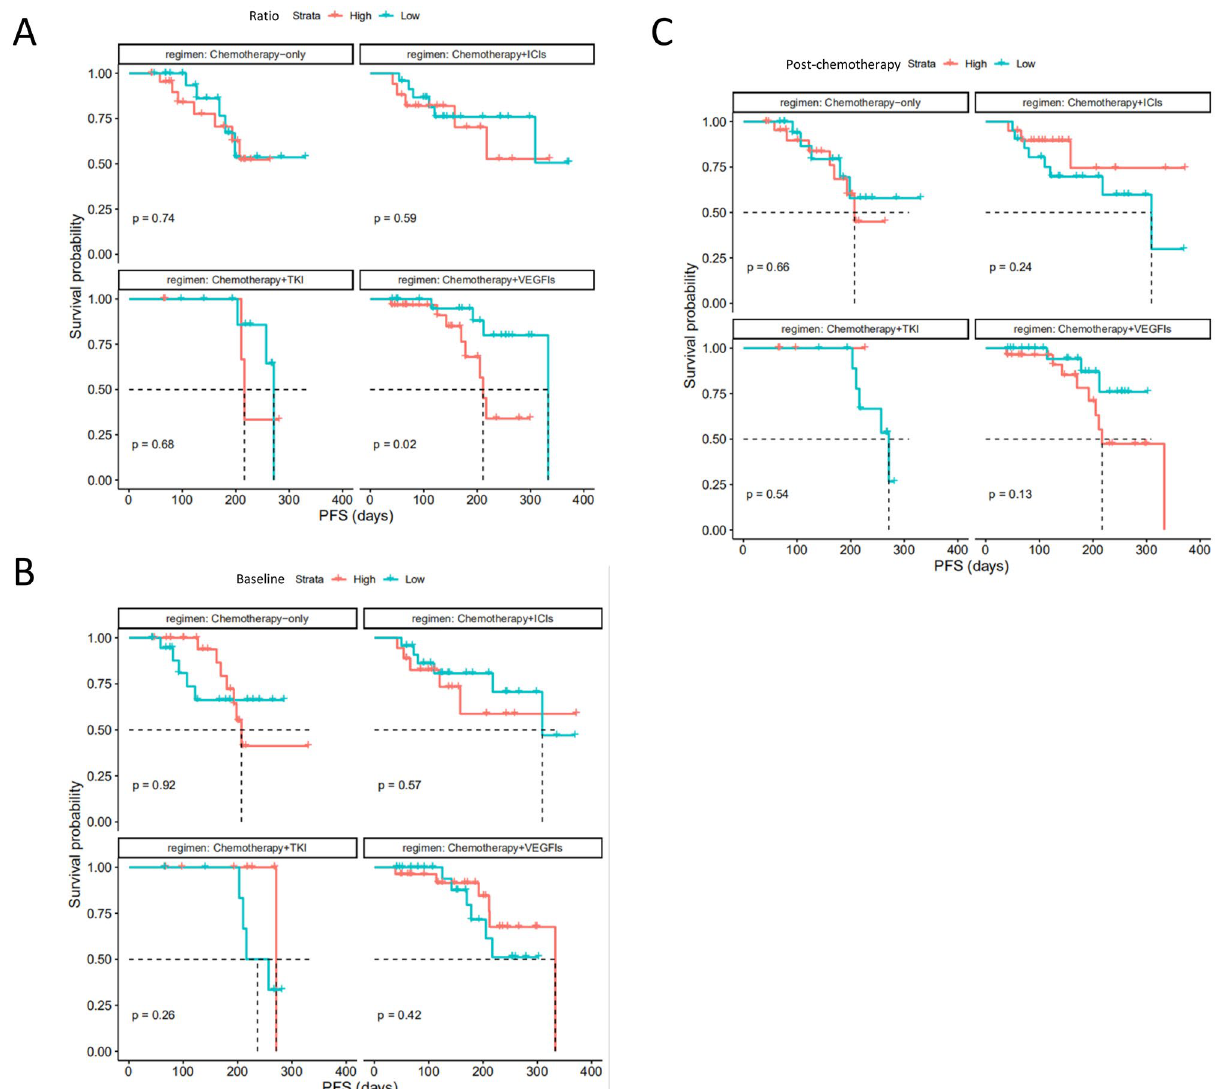
Figure 5. Progression-free survival (PFS)/disease free survival (DFS) in subgroups by therapy regimen. Stratified analysis of Kaplan–Meier curves by therapy regimen (chemotherapy alone ( N = 45), chemotherapy plus TKIs ( N = 15), chemotherapy plus VEGFIs ( N = 53), and chemotherapy plus ICIs ( N = 41)) for comparisons of PFS/DFS between ( A ) high cfDNA Ratio and low cfDNA Ratio groups, ( B ) high cfDNA baseline and low cfDNA baseline groups, ( C ) high post-therapy cfDNA and low post-therapy cfDNA groups (cut-values were set as median value), respectively. PFS/DFS was assessed according to Response Evaluation Criteria in Solid Tumors, version 1.1 through investigators’ review, and tick marks represent data censored at the last time the patient was known to be alive and without disease